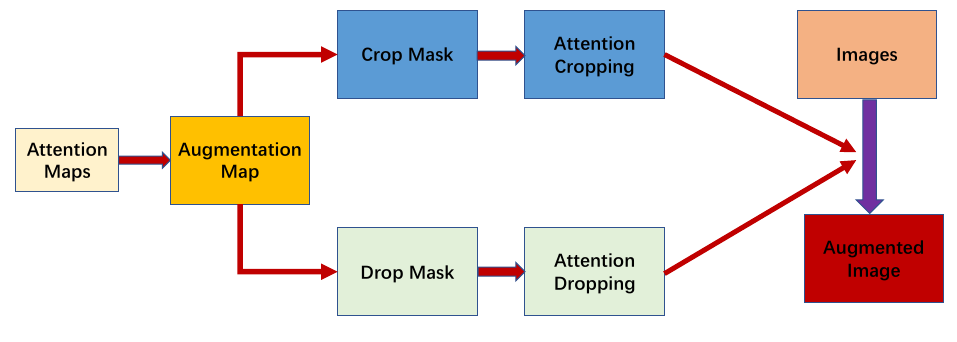
Figure 2. The architecture of Attention Guide